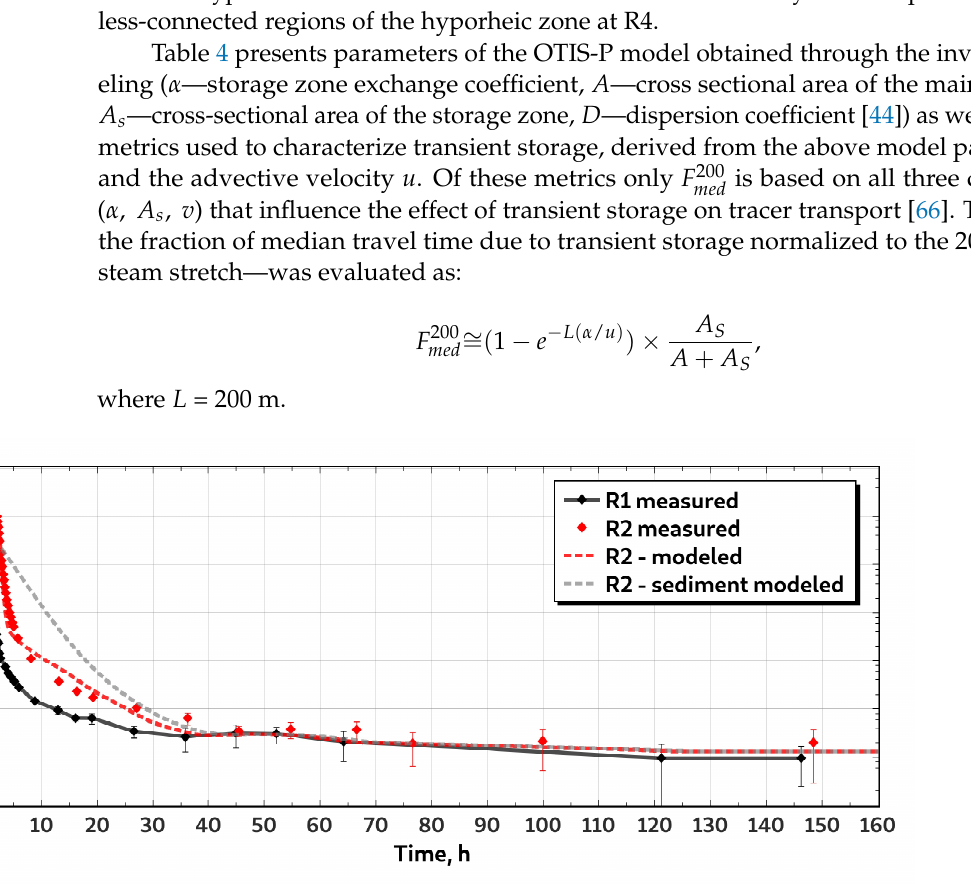
Figure 3. The 3 H activity concentrations observed at R1 and R2, and modeled at R2. Observations in sediment were not performed at R2.